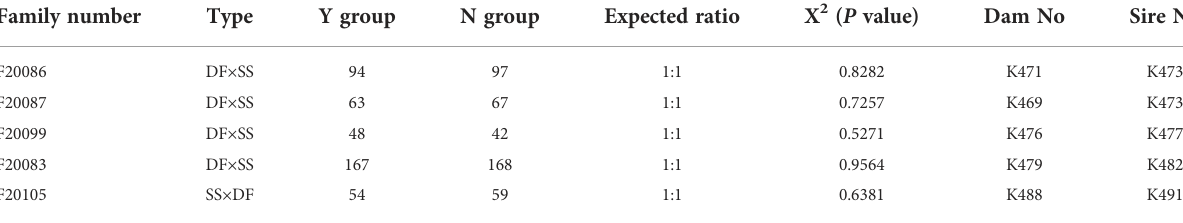
TABLE 1 Segregation statistics of mantle markings in fi ve three-way cross abalone families. Family number